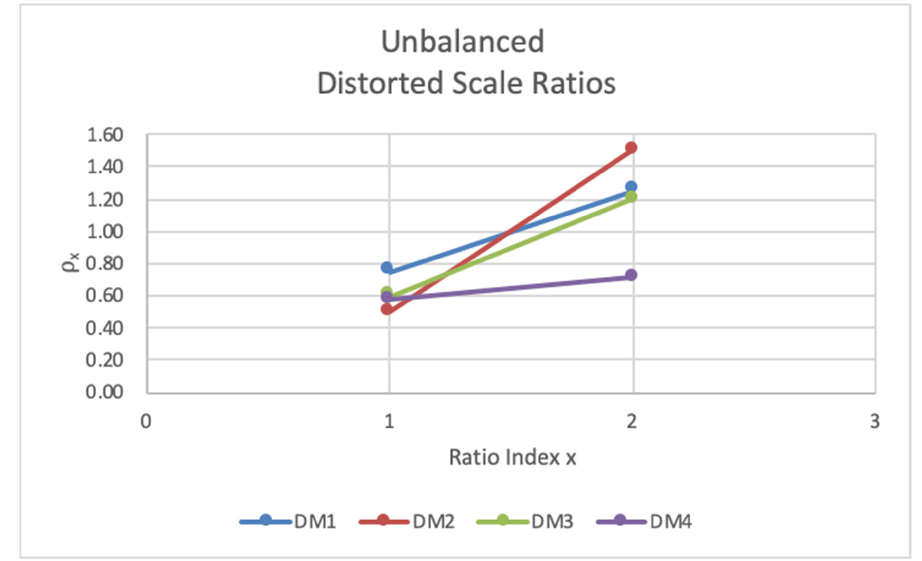
Figure 4. Unbalanced distorted scale ratios between decision makers.